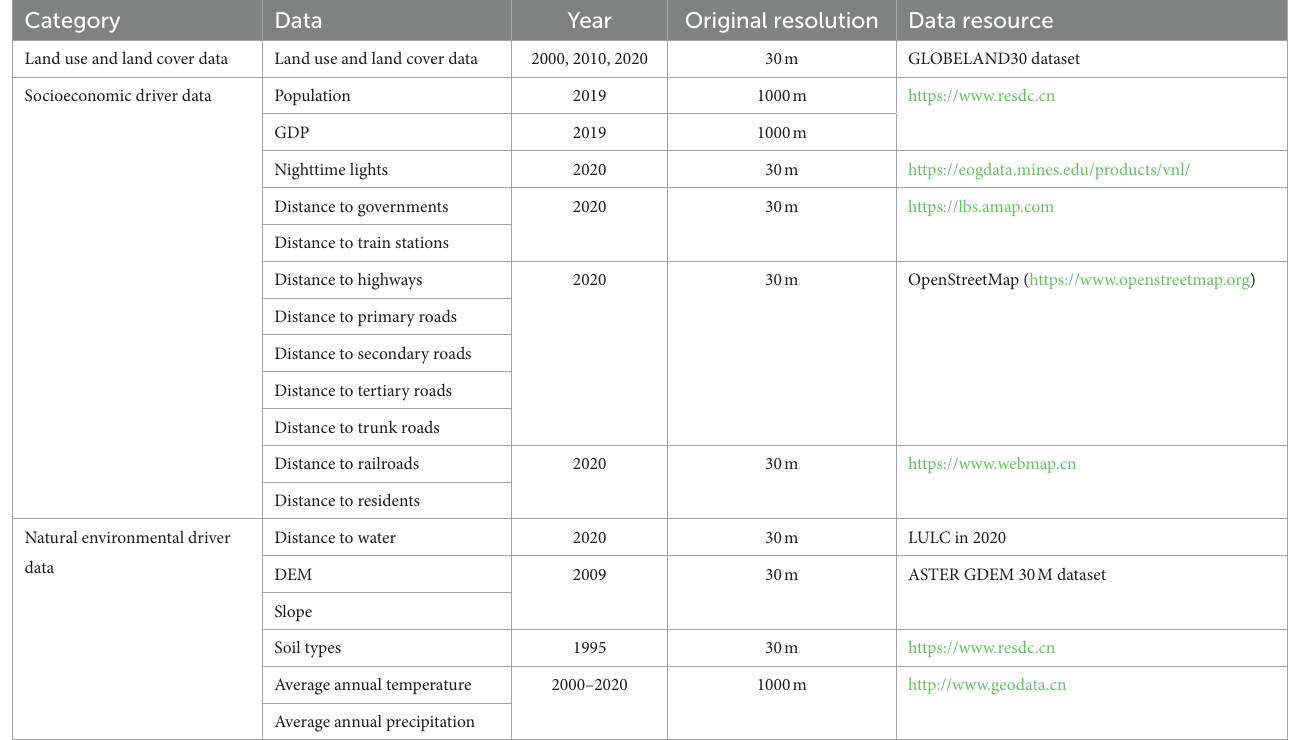
TABLE 1 Spatial driving factors of the land use change in this